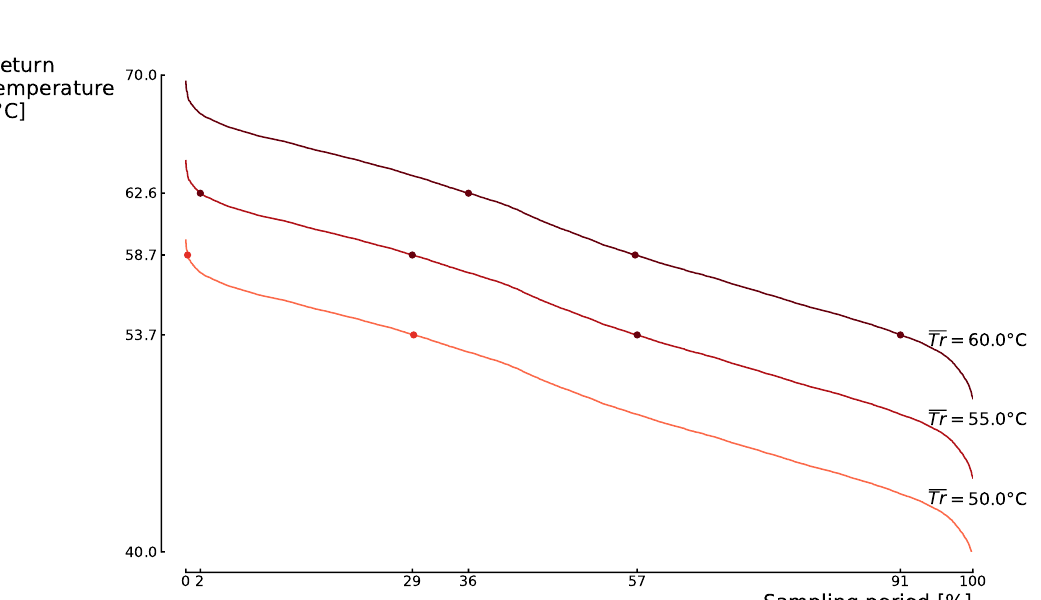
Figure 5. Return temperature duration curves over the sampling period for the different scenario investigated. The period of time where the return temperatures are below the dew points corresponding to 30, 40, and 50% fuel moisture content are highlighted by dots.